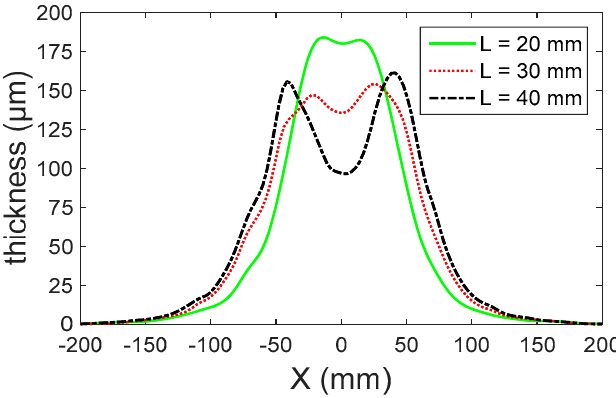
Figure 15. Coating thickness profiles along the x- axis for different L values when θ = 10°.